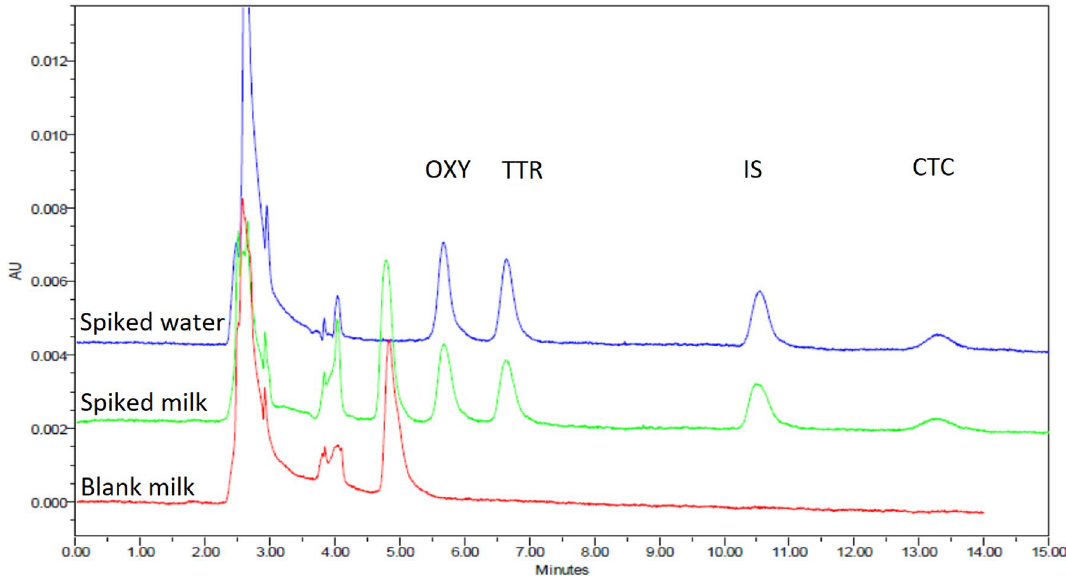
Figure 6. Selectivity of cow’s milk matrix. mobile phase: 10 mM KH 2 PO 4 :ACN: MeOH (70:20:10), pH 4.